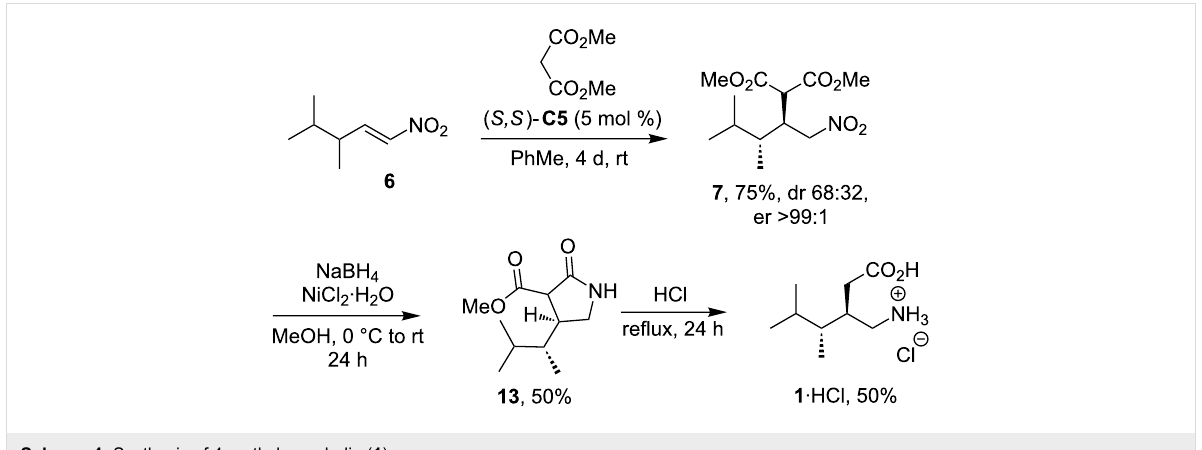
Scheme 4: Synthesis of 4-methylpregabalin ( 1